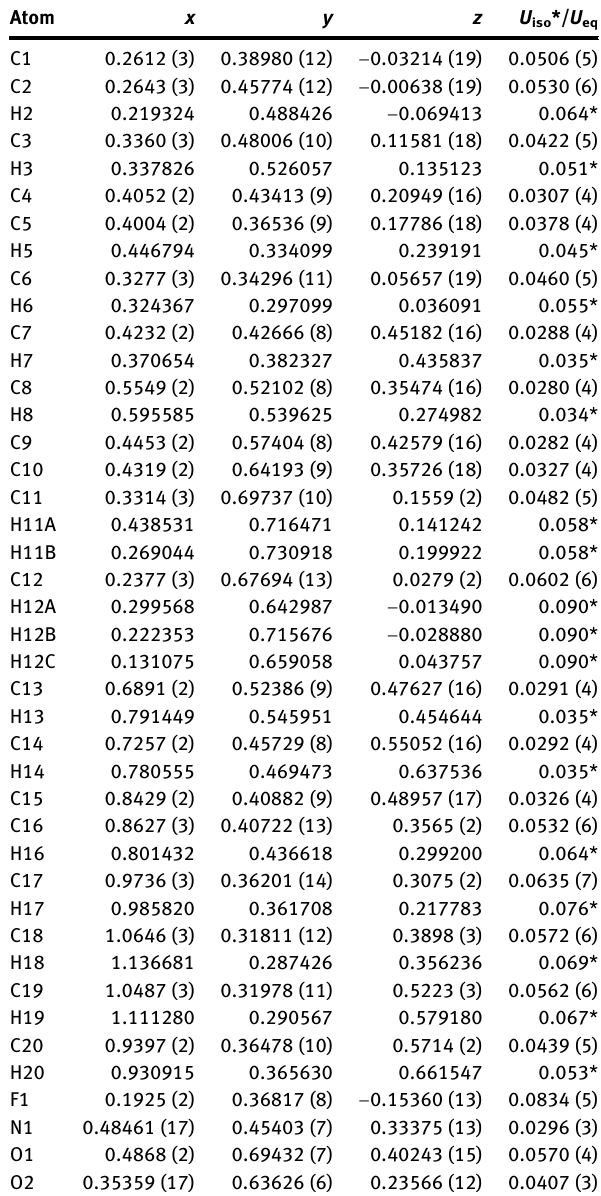
Table  : Fractional atomic coordinates and isotropic or equivalent isotropic displacement parameters (Å 